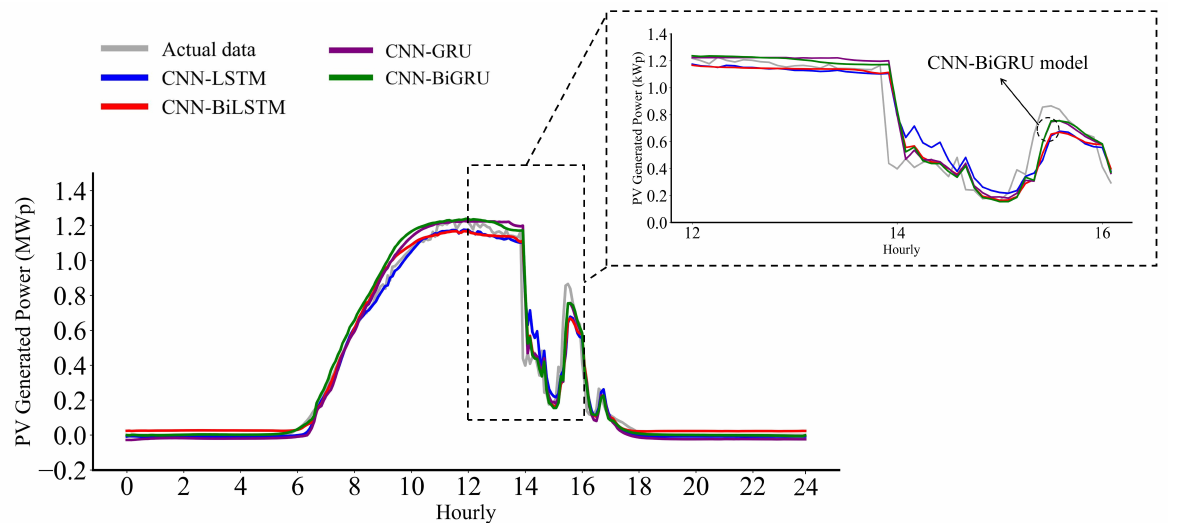
Figure 10. One-day PV generation forecasting on a cloudy weather day obtained by the hybrid model and compared with actual PV generation data. The inset figure shows the forecasting performance of the hybrid model between 12 and 16 h. In the hybrid deep learning model, the most preferable model for the short-term prediction of the PV power generation on a cloudy weather day is CNN- BiGRU